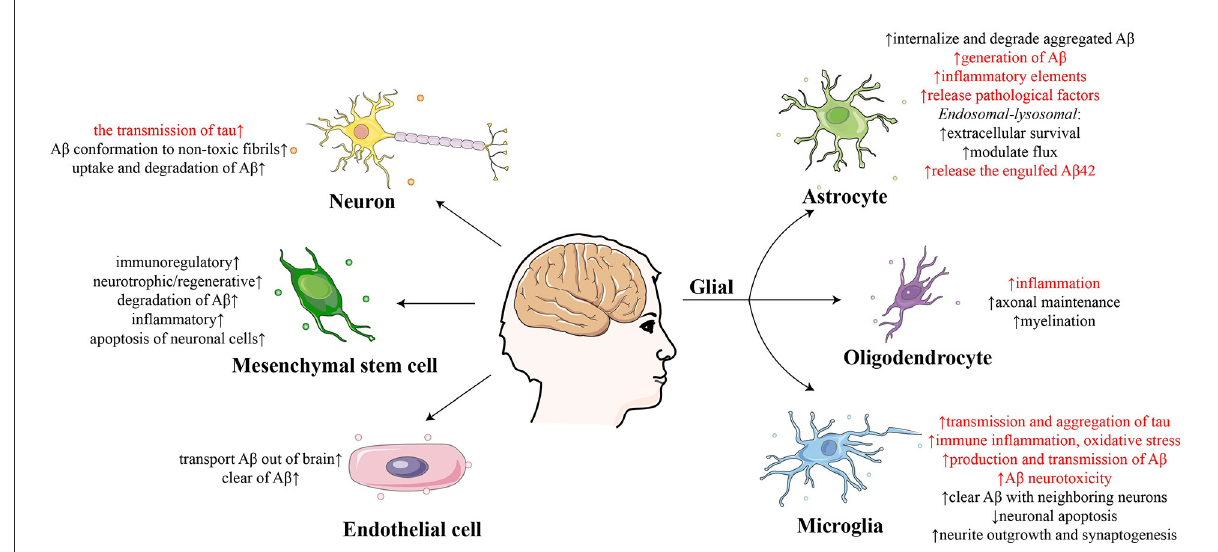
FIGURE1 Summary of the effect of exosomes derived from different cells on the development of Alzheimer’s